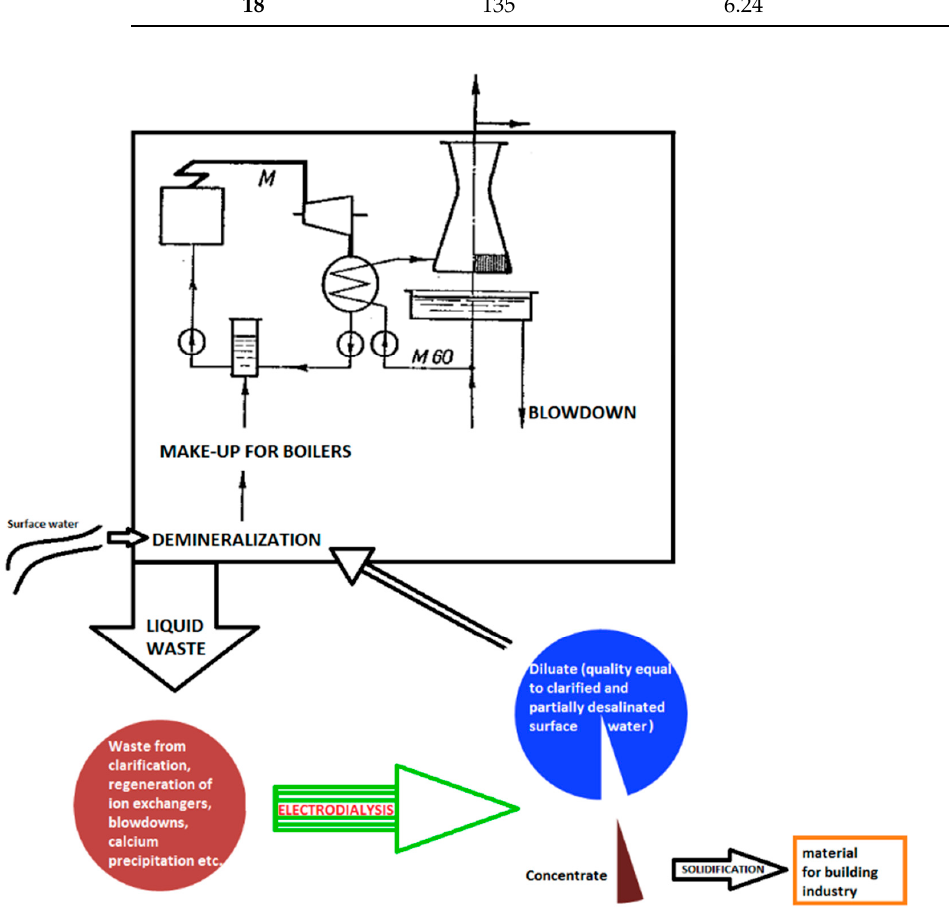
Figure 12. Treatment of mixture of liquid waste from power plant or heating station using combination of sludge filter press and electrodialysis: zero liquid discharge [1,6,8] .